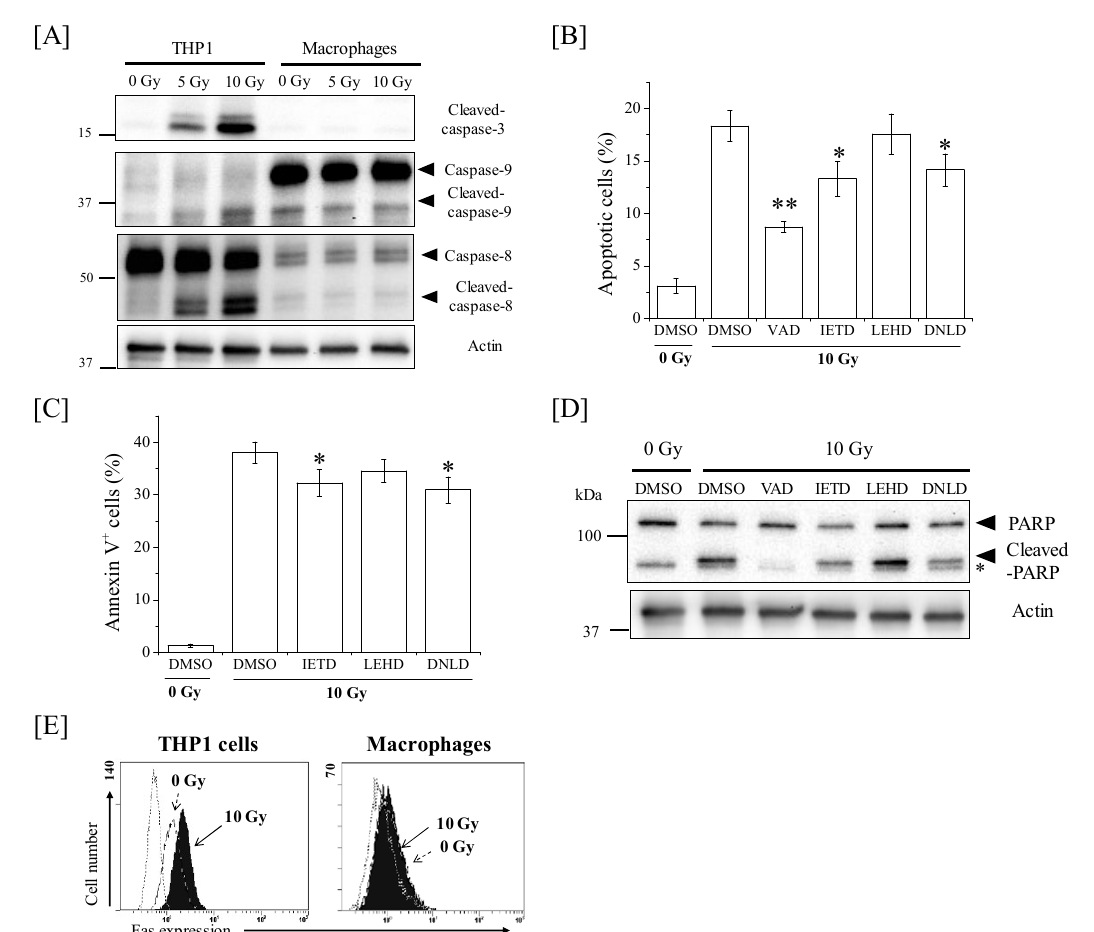
Figure 4. Involvement of caspases in X-ray-irradiated THP-1 cells. ( A ) THP-1 cells and macrophages were exposed to 10-Gy X-ray irradiation. The cells were cultured for 48 h and then harvested for Western blot analyses of caspase-3, -8, and -9. The expression of β -actin was analyzed as a loading control. ( B – D ) THP-1 cells pretreated with caspase inhibitors or dimethyl sulfoxide (DMSO) were exposed to 10-Gy X-ray irradiation. The cells were cultured for 48 h and harvested for the detection of apoptosis ( B ), cell death analyses ( C ), and Western blot analyses ( D ). ( B , C ) Data are presented as the mean ± SD of three independent experiments. * p < 0.05, ** p < 0.01; comparisons made against DMSO +10-Gy irradiation. ( D ) Representative data from the Western blotting of poly ADP ribose polymerase (PARP) are shown. The expression of β -actin was analyzed as a loading control. The asterisk indicates a non-specific band. ( E ) THP-1 cells and macrophages exposed to 10-Gy X-ray irradiation were cultured for 24 h and 48 h, respectively. The cells were harvested for the analysis of cell surface Fas expression. Representative histograms are shown. The dotted line histogram indicates cells stained with isotype control. The broken line and filled gray histograms indicate the Fas expression in non-irradiated cells and 10-Gy X-ray-irradiated cells, respectively.